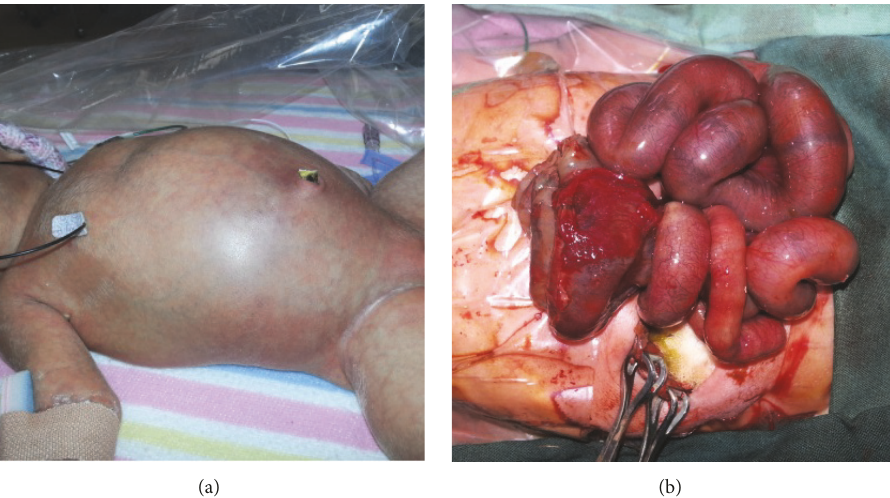
Figure 4: Clinical photos: (a) clinical appearance of infant on day 2 of life with erythematous, distended abdomen, and (b) in operating theatres ileal volvulus visible with a necrotic segment on the left